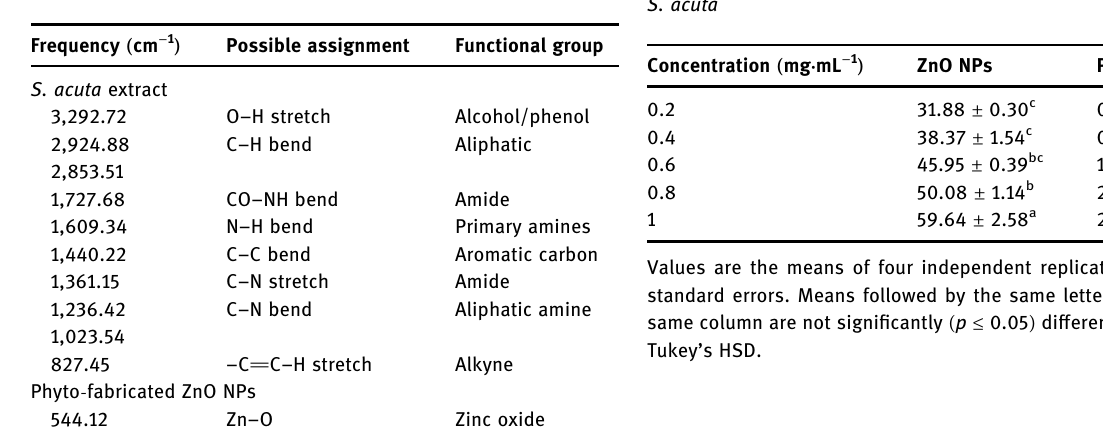
- fabricated ZnO NPs from